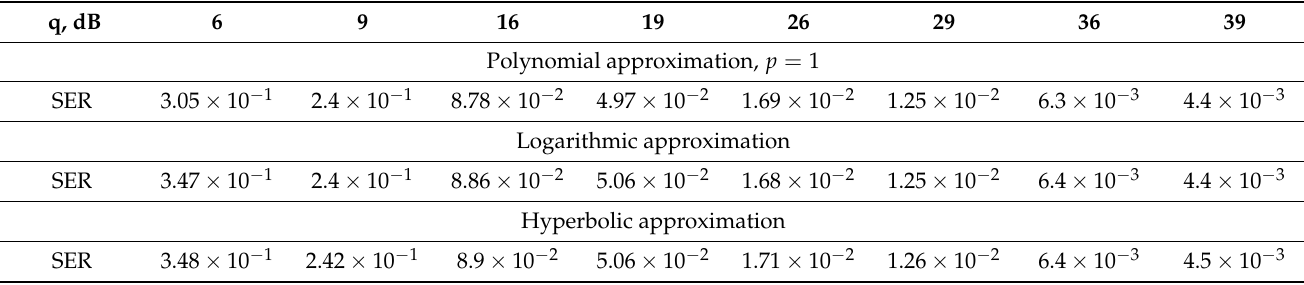
H i H i and their estimation based on the test signal versus time: ( ), ( ) Figure 10. Channel gains H 1 c ( i ) , H 1 s ( i ) and their estimation based on the test signal versus time: Figure 10. Channel gains c s 1 1 the algorithms, described by Equations (5)–(9) and (12) with p = 1 was used—( a ), SNR = 26 dB; the the algorithms, described by Equations (5)–(9) and (12) with 1 p = was used—( a ), SNR = 26 dB; the enlarged fragment of “a)” part of the Figure—( b ). enlarged fragment of “a)” part of the Figure—( b ). Table 7. SER of 16-QAM versus SNR per bit for m = 50, n 1 = 20, K 0 =